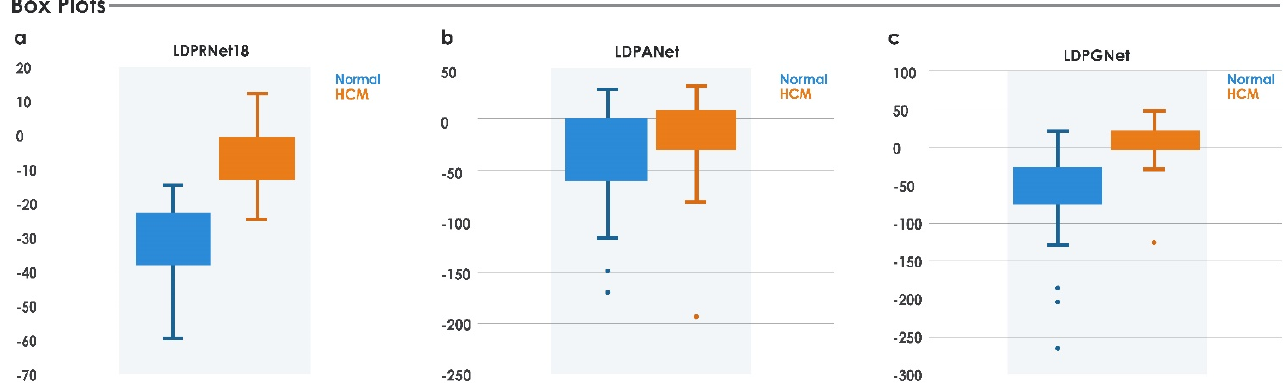
Figure 10. Index application to RNet18, ANet, and GNet features.